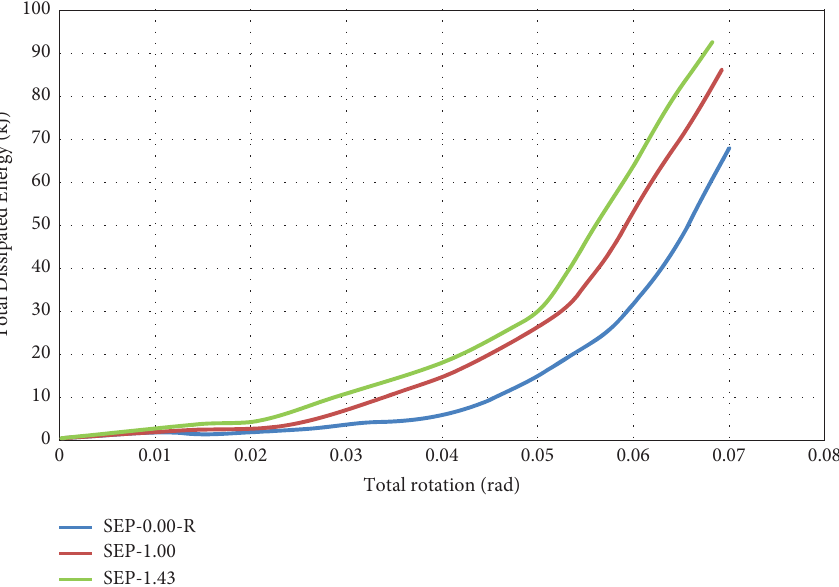
Figure 9: Total dissipated energy of the specimens during the loading